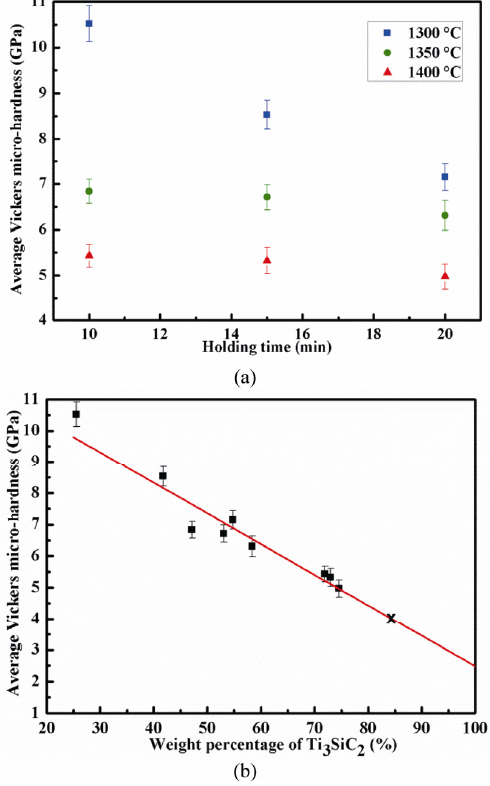
samples as function of (a) holding time at different sintering temperatures and (b) weight percentage of Ti 3 SiC 2